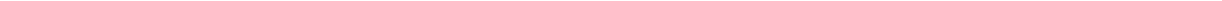
Fig. 3 MAR de fi nes drug sensitivity of human multiple myeloma ANBL-6 and MM.1 cells to bortezomib-dexamethasone combination. a , b MAR per mass of ANBL-6 and MM.1 cells treated in dimethyl sulfoxide (DMSO), 5 nM bortezomib, 200 nM dexamethasone and their combinations for 3 h. MAR per mass of ANBL-6.WT cells (bortezomib and dexamethasone sensitive) reduces upon the exposure to bortezomib and dexamethasone, while that of ANBL-6.BR cells (bortezomib resistant and dexamethasone sensitive) reduces only upon the exposure to treatment containing dexamethasone. MAR per mass of MM.1S cells (bortezomib and dexamethasone sensitive) reduces upon the exposure to bortezomib and dexamethasone, while that of MM.1R cells (dexamethasone resistant and bortezomib sensitive) reduces only upon the exposure to treatment containing bortezomib. Boxes represent the inter- quartile range and white squares are the average of all measurements. p values were calculated using Welch ’ s t -test, comparing treated cells to control (cells seeded only in culture media), and were Bonferroni corrected. **** p < 10 − 4 in highlighted segments. For ANBL-6.WT cells; p (DMSO vs. DMSO